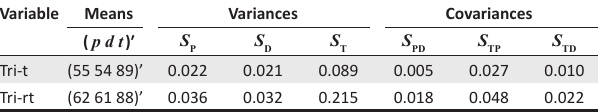
TABLE 2: Means, variances, covariances and 95 % distribution ellipsoids for the Trivector test and retest measurements. Variable